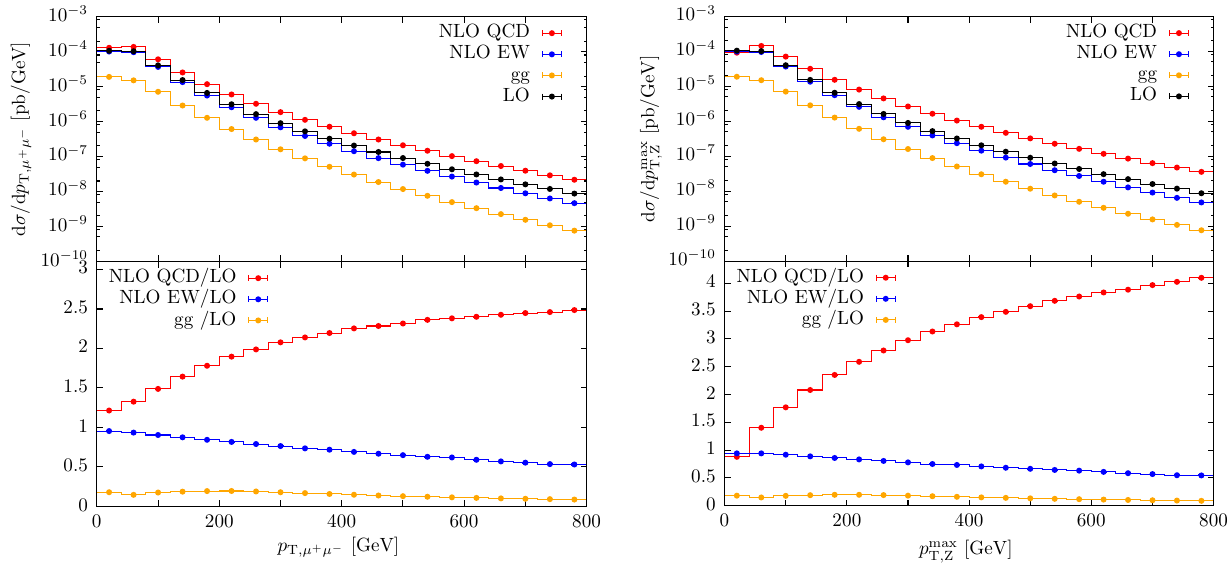
Fig. 17 Differential distribution in the muon–antimuon-pair transverse momentum ( p T ,μ + μ − ) and in the hardest Z-boson transverse momentum √ s = 13TeV under the event selections of Eq. (4.11). Same notations and conventions as in Fig. 16 ( p max ) for the process pp → e + e − μ + μ − at T , Z